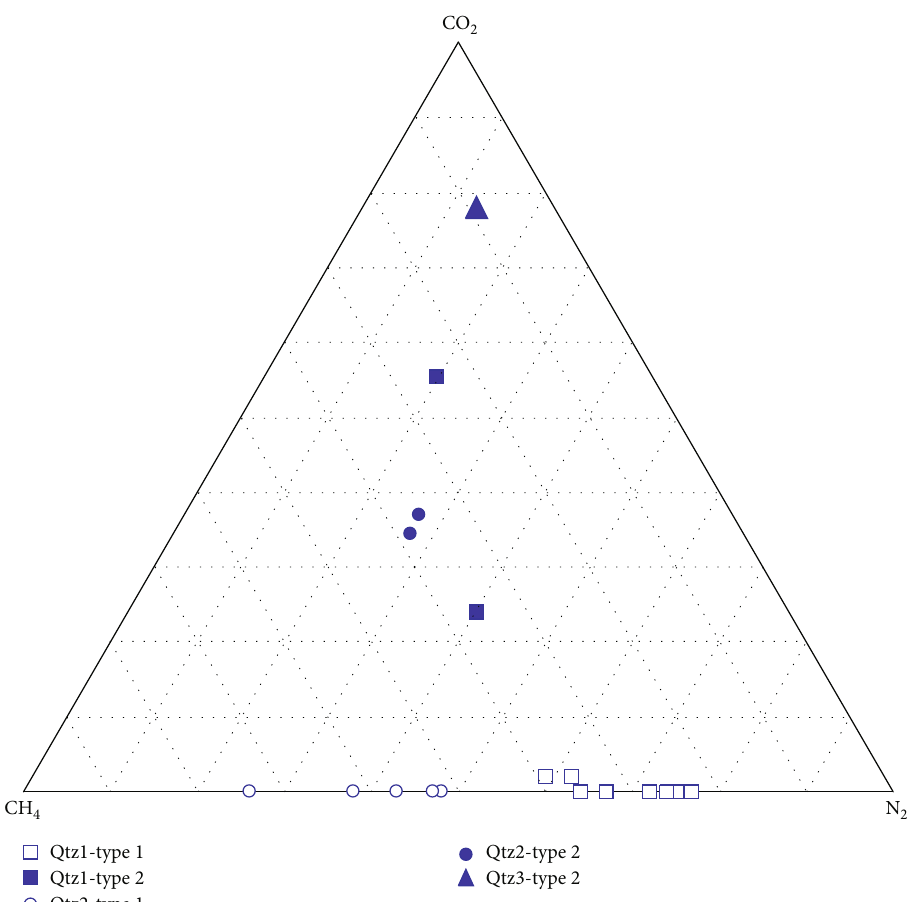
Figure 9: Compositional ternary diagram showing the repartition of gas phases in fl uid inclusions of quartz-mineralised veins of the Roc Blanc